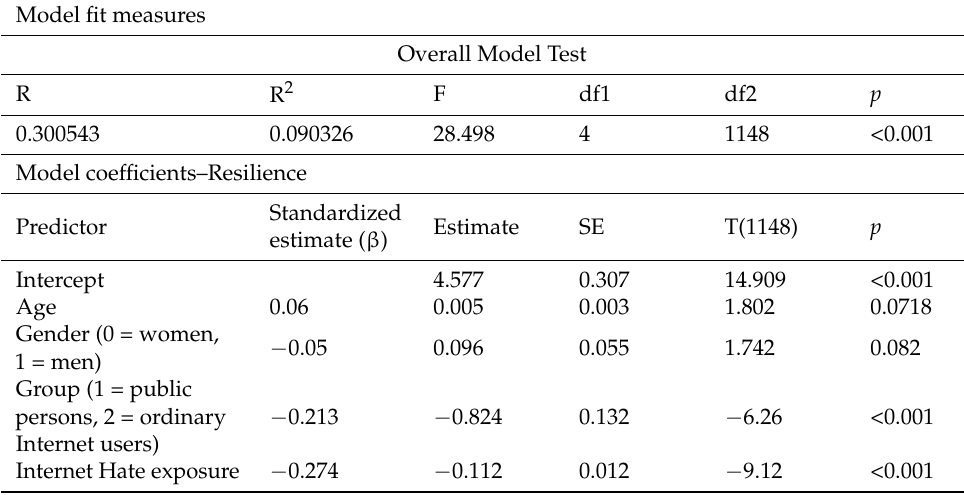
Table 4. Regression model predicting higher Resilience ( n = 1153).